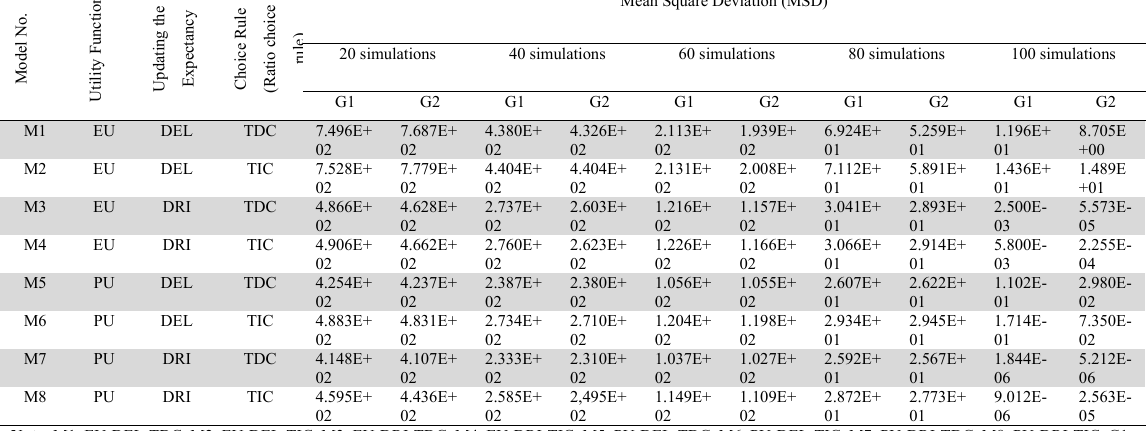
MSD value of all models for all simulation value for both experienced and inexperienced group . N o l od e M